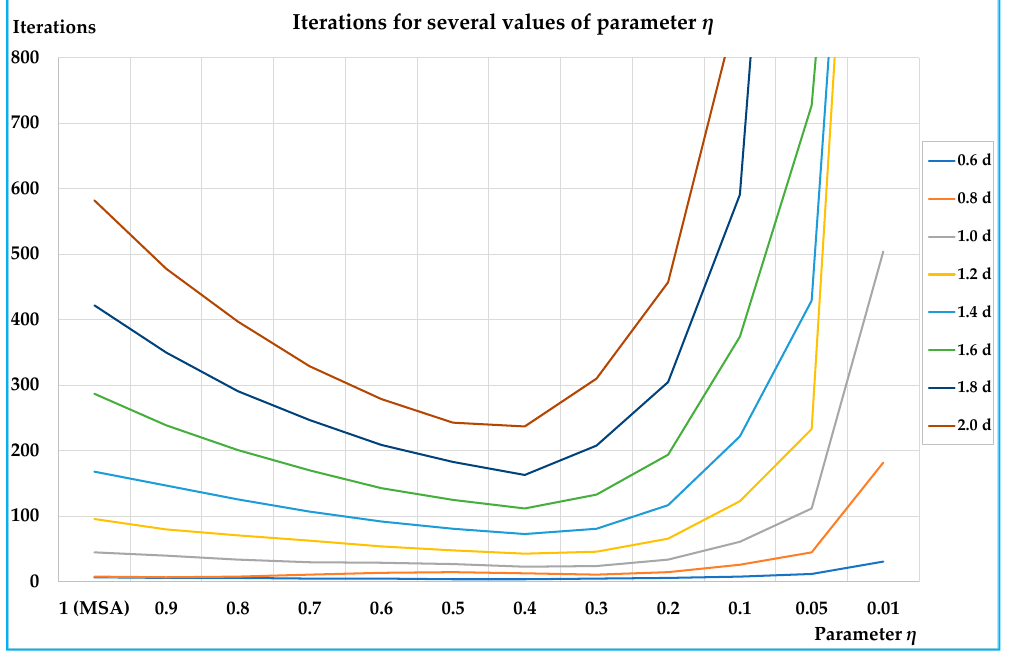
Figure 3. Results on the small network. Table 4. Results on the small